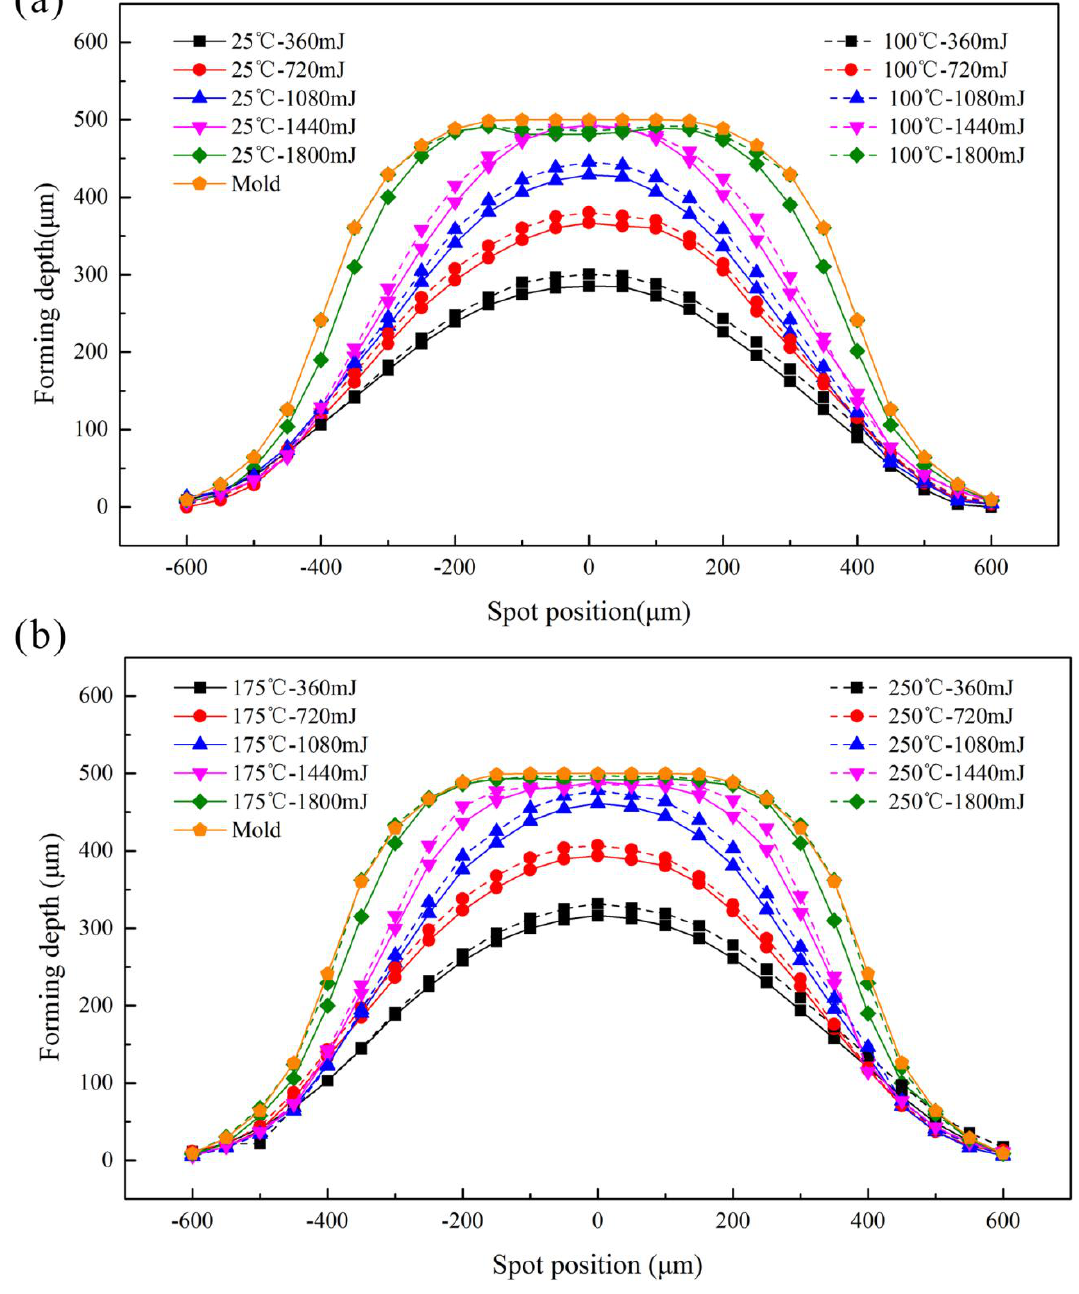
Figure 17. Effects of laser energy on the forming symmetry at different temperature: ( a ) at 25 °C and 100 °C, ( b ) at 175 °C and 250 °C.